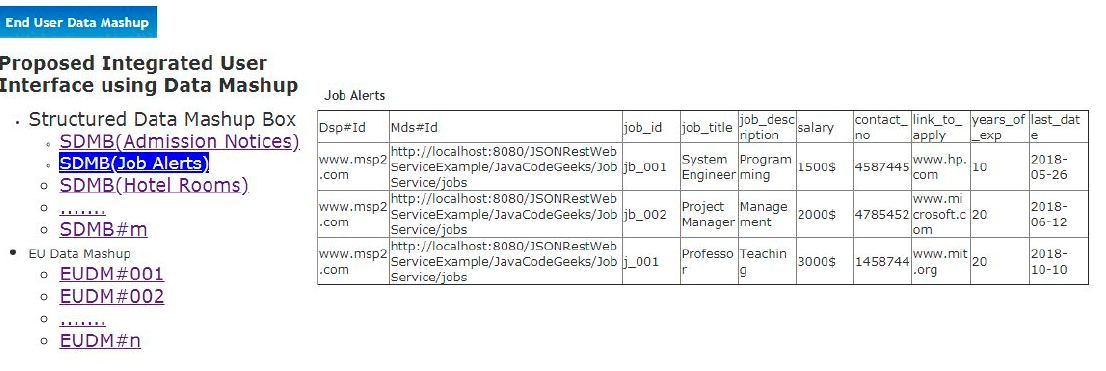
Figure 11. SDMB#02 (Job Alerts).